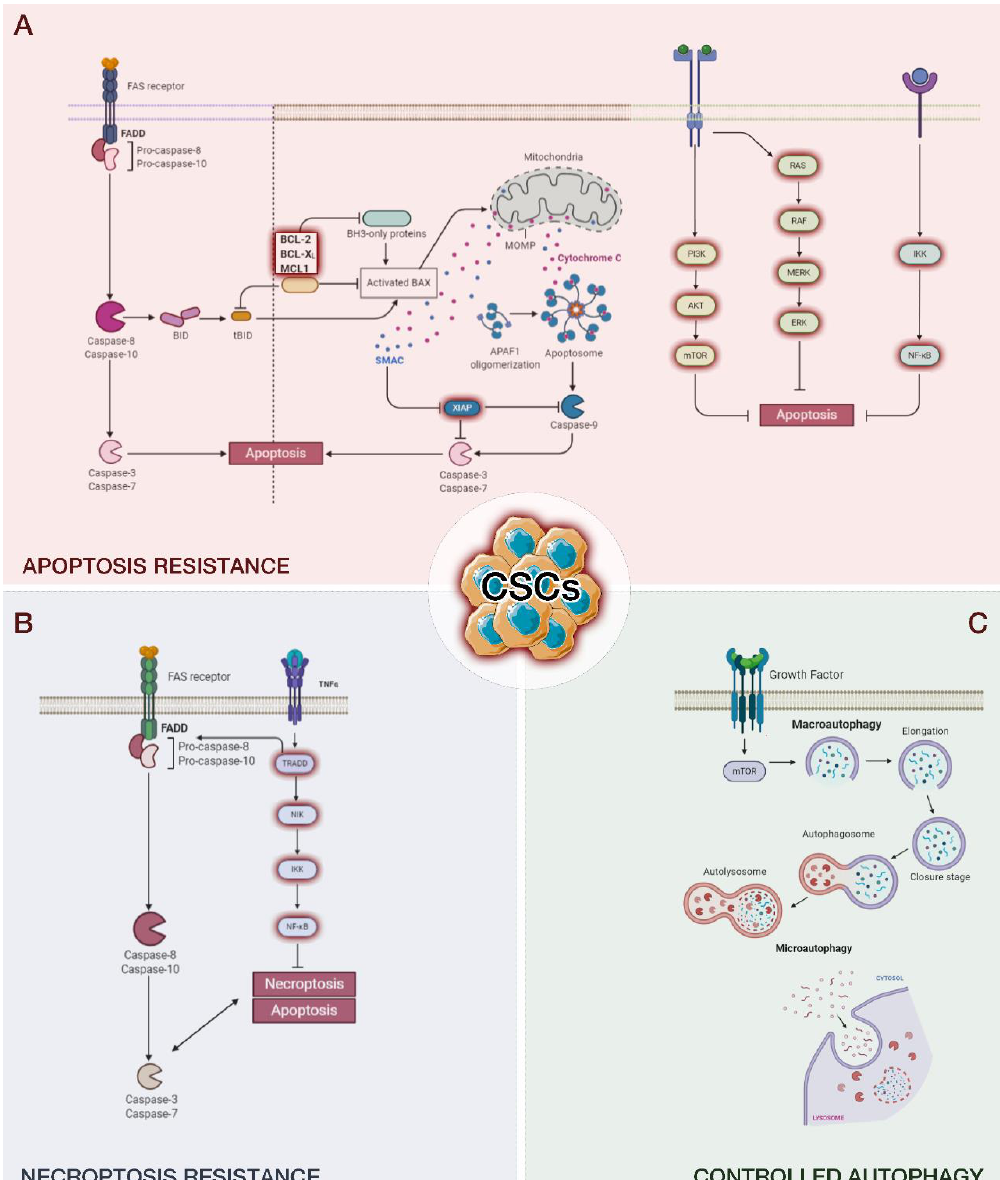
Figure 1. The ability of cancer stem cells (CSCs) to escape different programmed cell deaths, including apoptosis ( A ), necroptosis ( B ), and autophagy ( C ). The remaining CSCs promote cancer